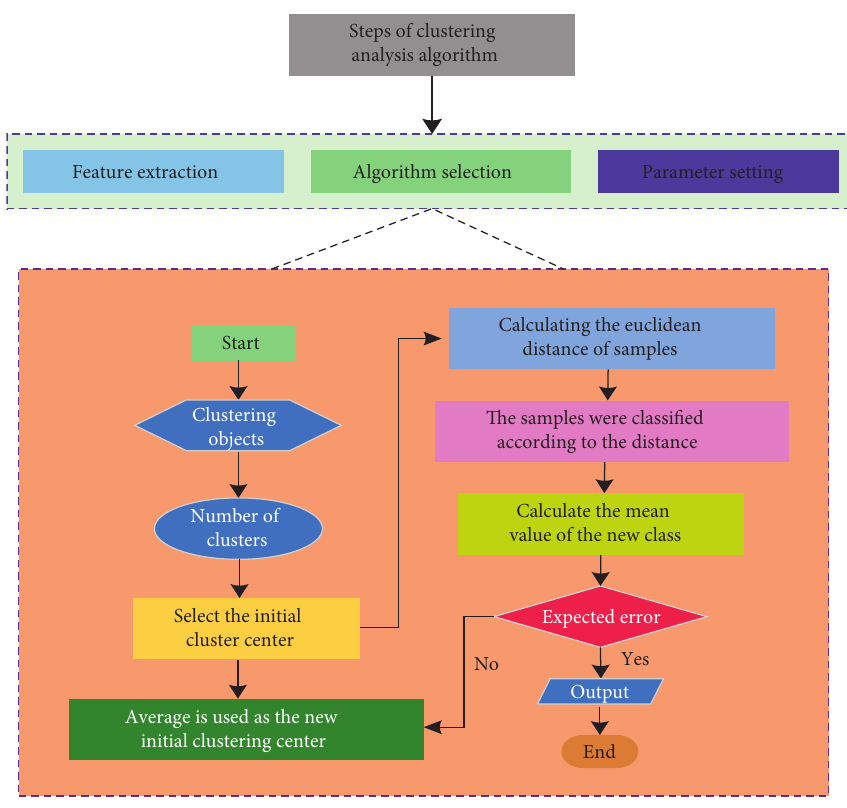
Figure 1: Flow chart of clustering analysis algorithm.